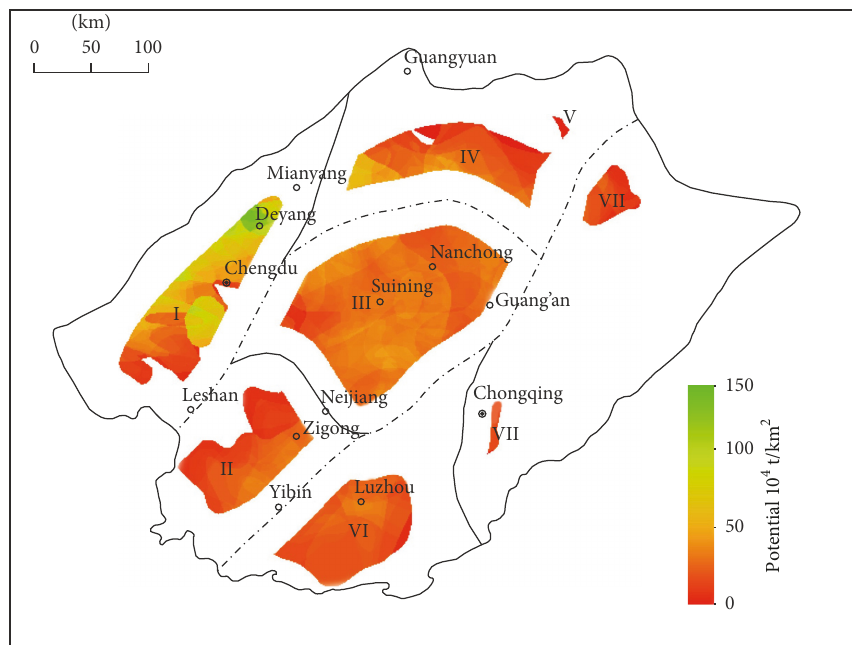
Figure 7: Storage potential per unit area for each prospective area. Due to the large stratigraphic thickness and many reservoir layers, the storage potential per unit area in most depressions in Northwestern Sichuan is quite large, with the largest up to 140 × 10 4 t/km 2 , at P 50 probability level. The storage potential per unit area in Central Sichuan is generally greater than 50 × 10 4 t/km 2 , at P 50 probability level.